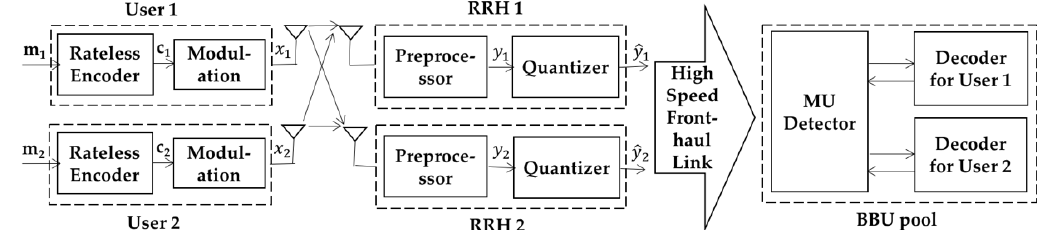
Figure 1. Rateless coded transmission for two-user uplink in cloud radio access network (C-RAN) with two remote radio heads (RRHs).